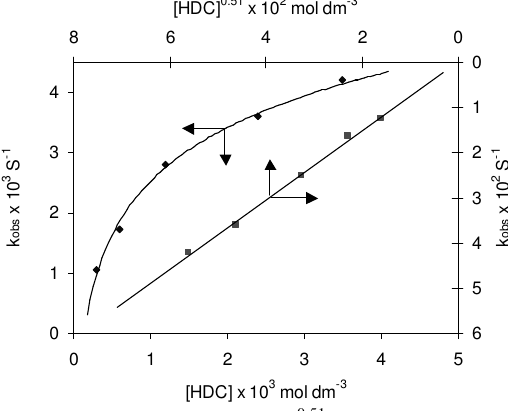
Figure 1. Plot of k